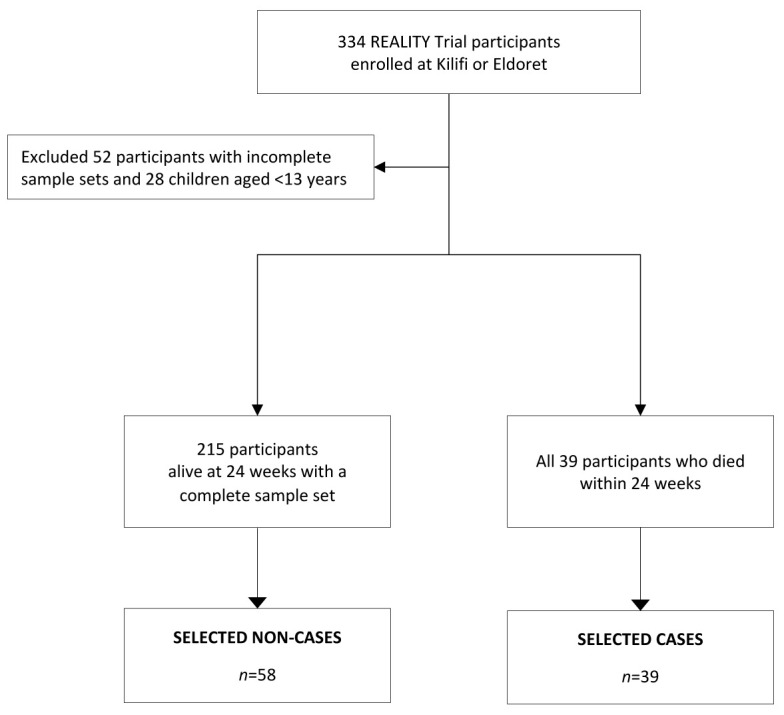
Participant selection.